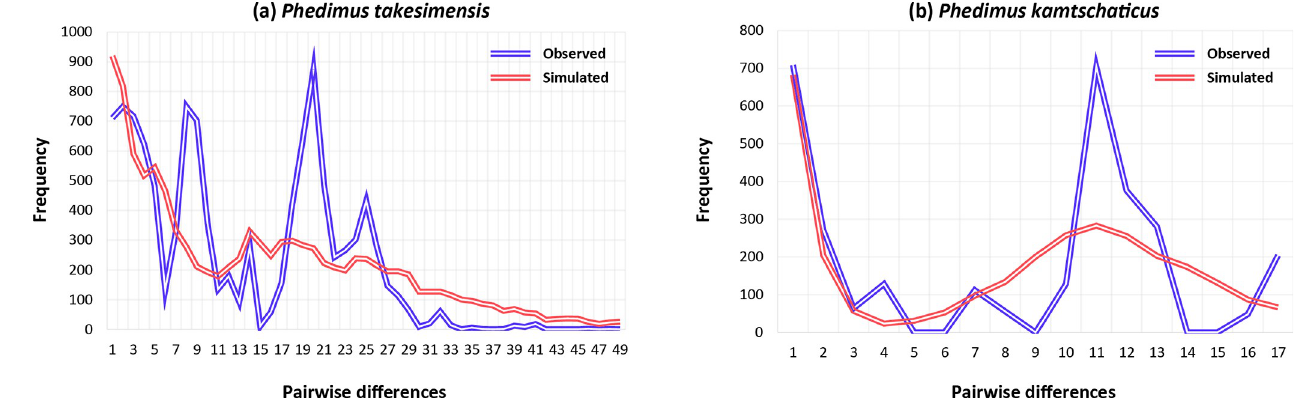
Fig 6. Mismatch analysis. Mismatch distribution analysis inferring the demographic history of Phedimus takesimensis (a) and P . kamtschaticus (b). The x-axis represents the number of pairwise differences, while the y-axis represents the relative frequency of pairwise comparisons. https://doi.org/10.1371/journal.pone.0239734.g006 (Fig 6). Group 2 included one population (HAK) of P . takesimensis from the northwestern part of Ulleung Island. Group 3 included two geographically close populations (TON and SAD) from the south-central part of Ulleung Island, while Group 4 included populations from the north facing (TEA, HYE, CHE, and SUM) and east facing (NAE, JEO, and DOD) part of the island. In the case of the three SAMOVA groups from the Korean Peninsula, Group 5 con- tained one central (UN), one northern (SAM), and three southern (GOO, JI, and MUD) popu- lations of P . kamtschaticus , while Group 6 generally contained eastern (YON and HAM) and western (MUN, AN, and DUK) parts of the P . kamtschaticus populations. Group 7 exclusively contained two populations (HWA and TAE) of P . aizoon .